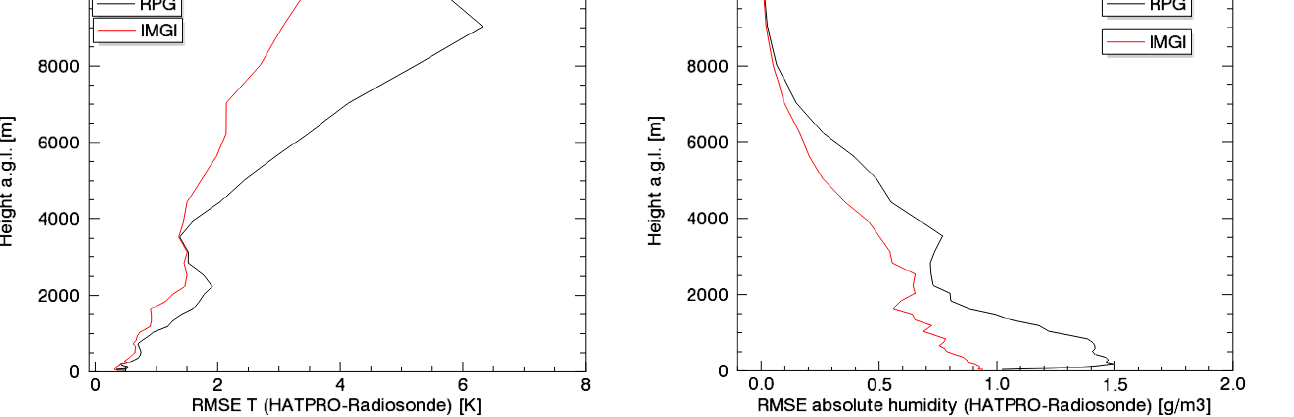
Figure 3. Comparison between RPG and IMGI algorithms for tem- perature profiles within the full troposphere. The RMSE is between temperature retrieved from the two algorithms and radiosonde in function of height (above ground). The 84 days refer to the time pe- riod from September 2012 to May 2013 and are all during the night. The radiosonde measurements are from the airport of Innsbruck and the profiler is located on the roof of IMGI.